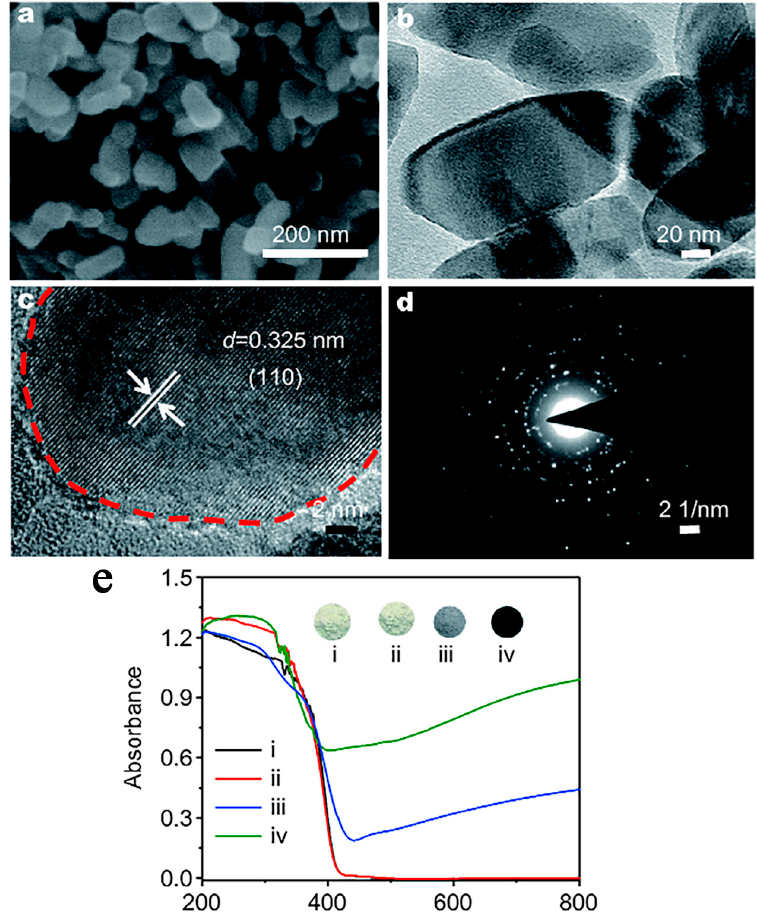
Figure 6. SEM ( a ), TEM ( b ), HRTEM images ( c ), the corresponding selected-area electron diffraction pattern ( d ) of the hydrogenated rutile TiO 2 (300 ◦ C) and the UV/vis absorption spectra ( e ) of the pristine rutile TiO 2 (i) and the hydrogenated rutile TiO 2 under 250 ◦ C (ii), 300 ◦ C (iii), and 350 ◦ C (iv). Reprinted with permission for ref. [87]. Copyright 2018,